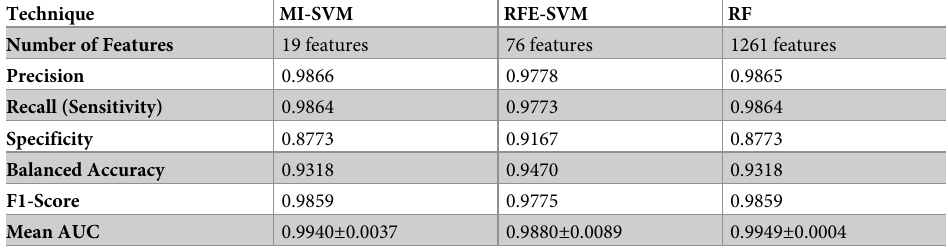
Table 1. A detailed evaluation table of MI-SVM, RFE-SVM, and RF models in terms of precision, recall, specific- ity, F1 score, and the mean AUC.